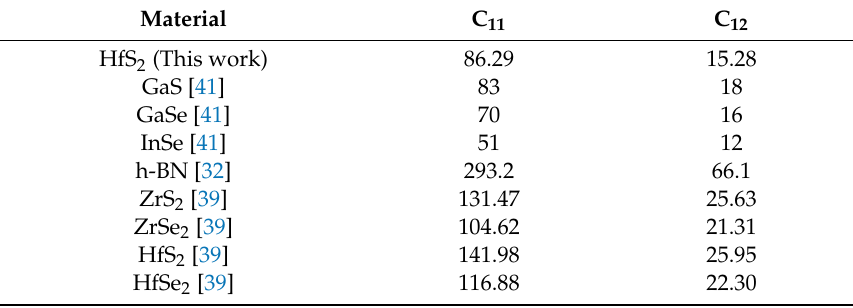
Table 4. Elastic constants C 11 and C 12 obtained in this work along with those reported in a previous works (in units of N / m).